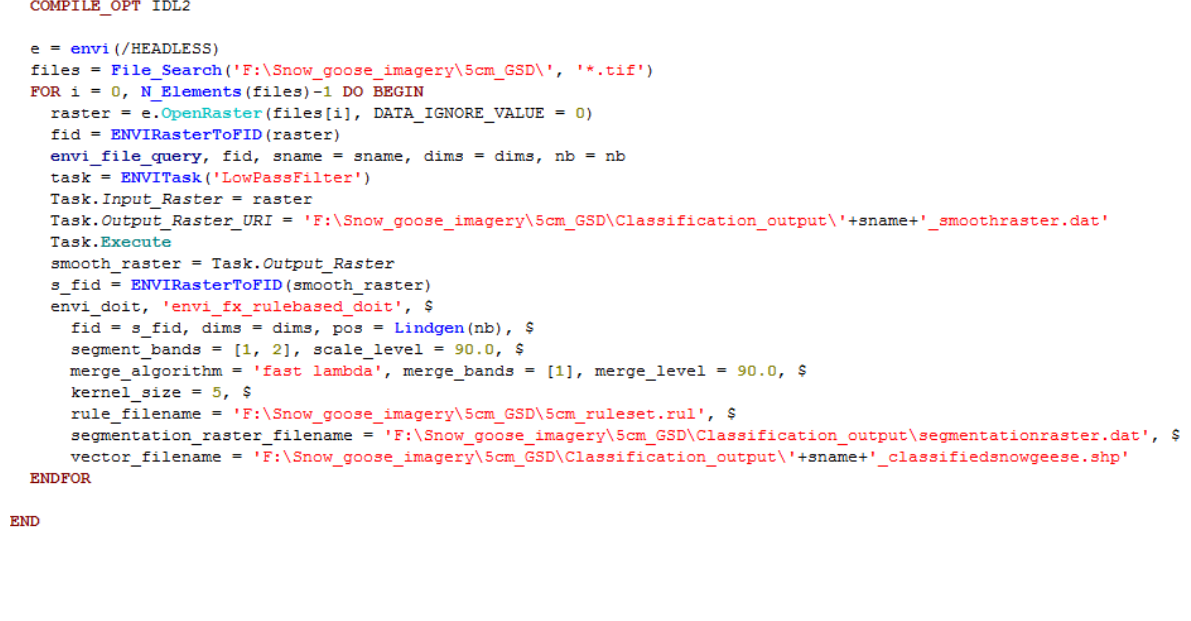
Fig. A10.1. Example IDL (Exelis Visual Information Solutions, Boulder, CO, USA) code